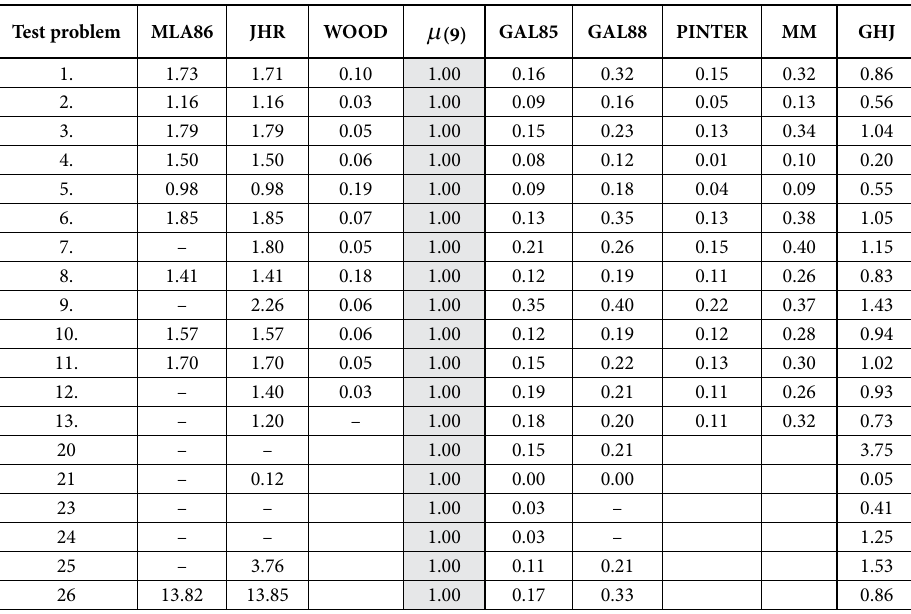
Table 5. Efficiency for n = 2, 3 test problems Test